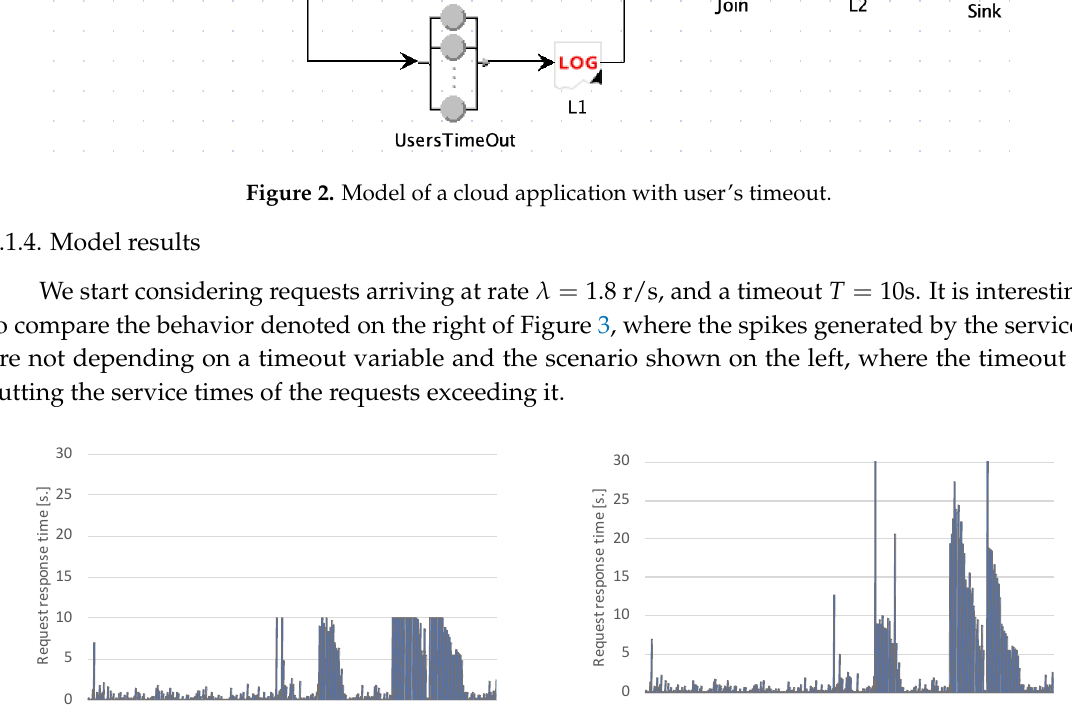
Figure 3. Response times with (left) and without (right) timeout of 10 s, for λ = 1.8 r/s and K = 2 VMs.